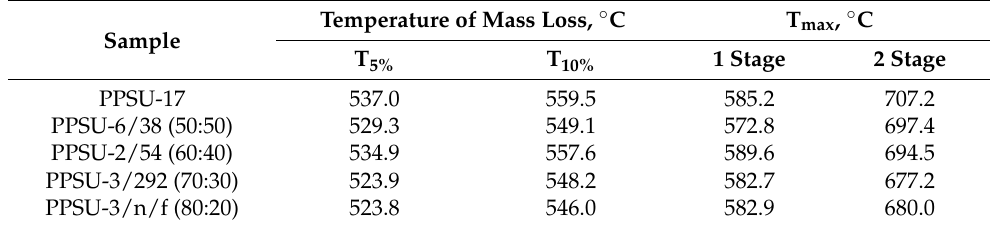
Table 2. Thermogravimetric analysis of PPSU blends.